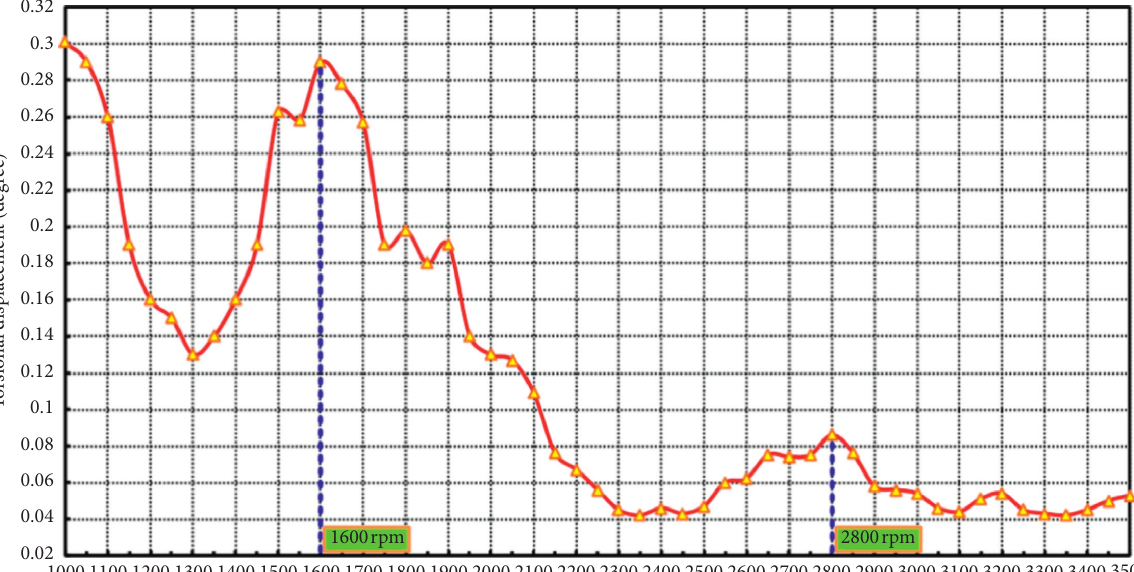
Figure 7: Amplitude-frequency response at input end of rear axle.